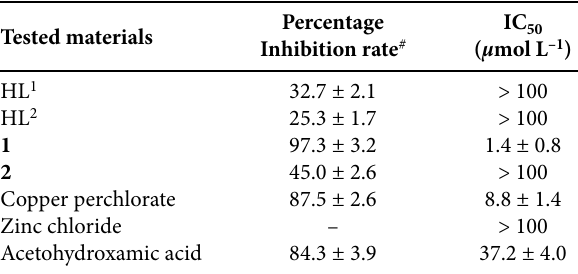
Table 4. Inhibition of urease by the tested materials Tested